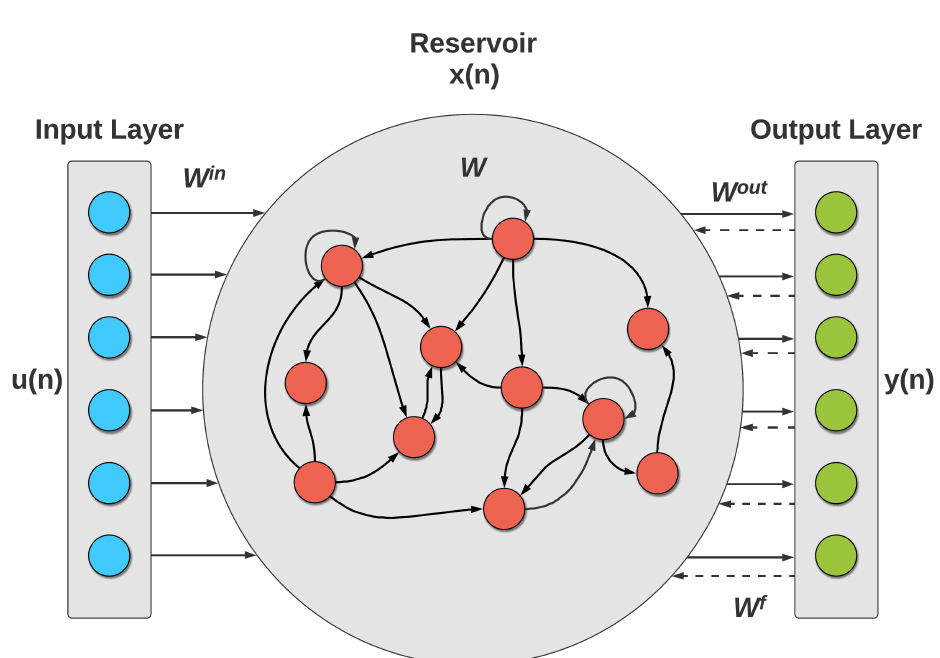
Figure 4. ESN Architecture, having a time series input, a reservoir of neurons with a specified activation function and a linear output